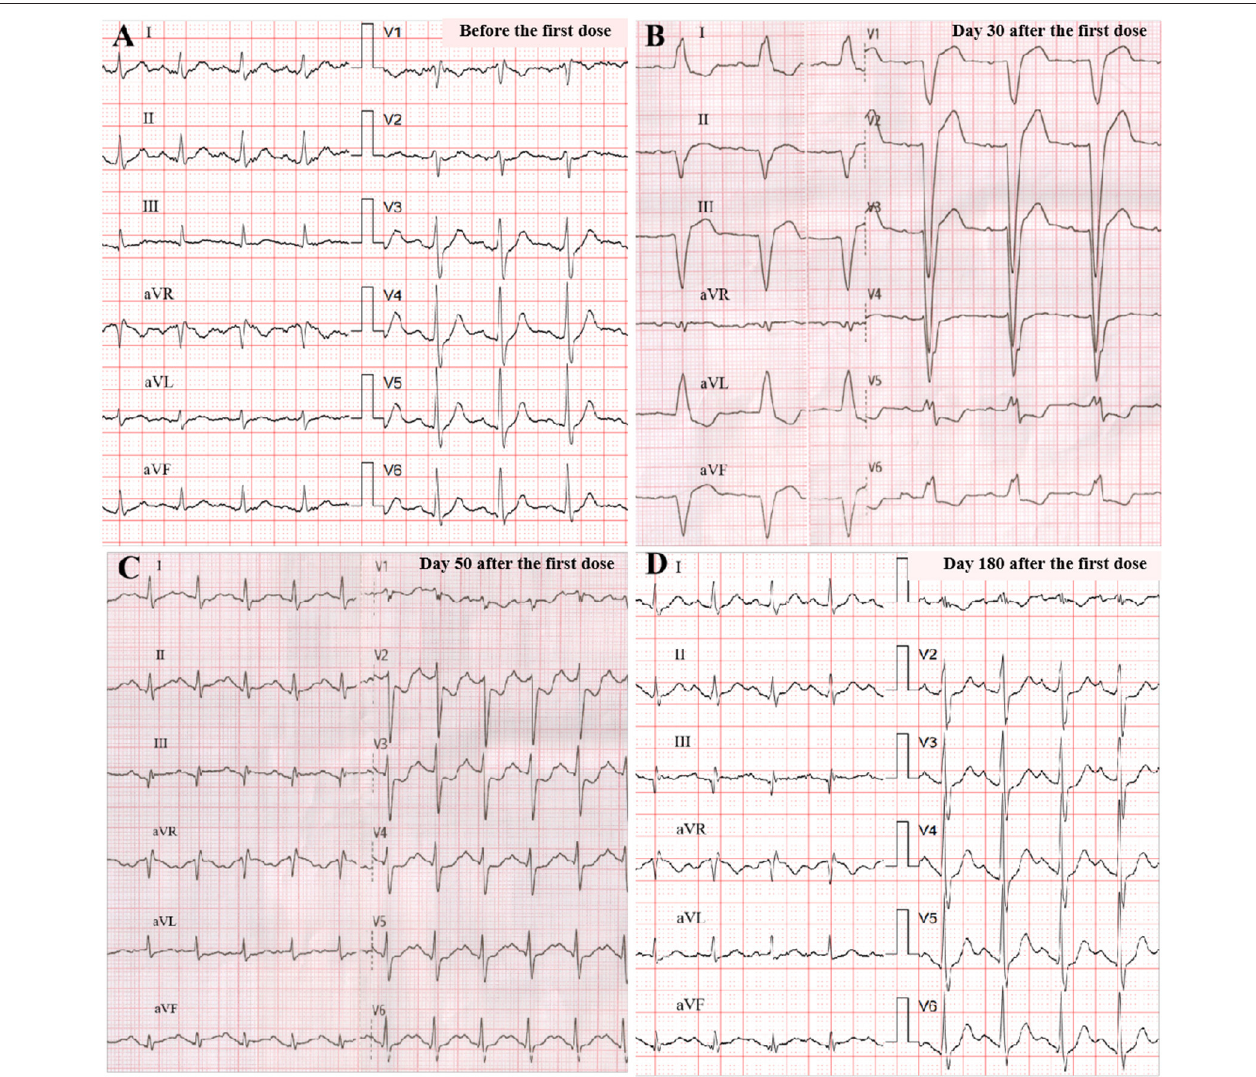
FIGURE 1 | ECG changes. Before programmed cell death receptor 1 (PD-1) inhibitor treatment (sinus 104 bpm, normal QRS of 106ms) (A) ; on admission (sinus 73 bpm, wide QRS of 156ms, left bundle branch block) (B) ; at discharge (sinus 125 bpm, normal QRS of 118ms) (C) ; at 6-month follow-up (sinus 113 bpm, normal QRS of 110ms) (D)